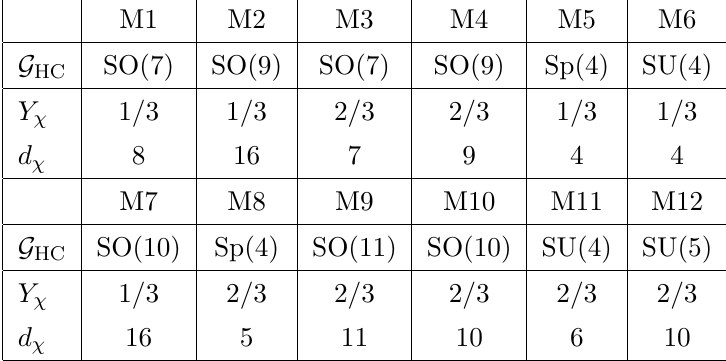
=(cid:20) is obtained t g